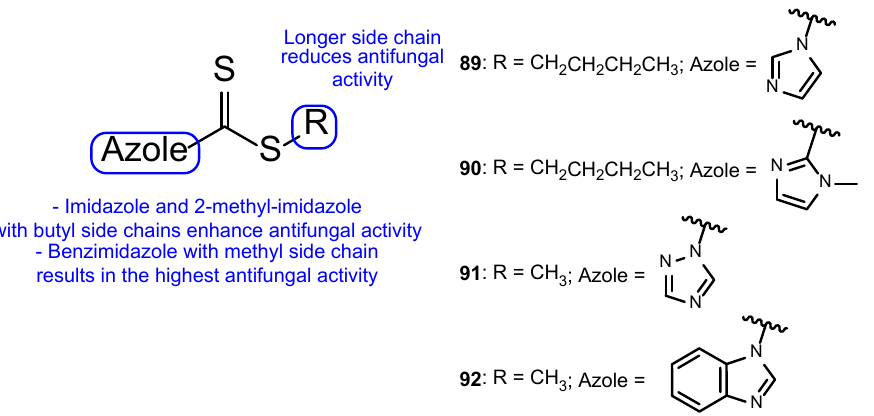
Figure 44. Chemical structure for compounds 89 – 92 , and SAR for the tested series of azole-carbodithioate hybrids [124].